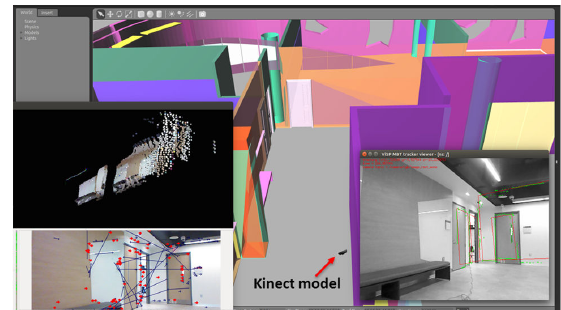
Figure 14: Screen capture of ViSP (bottom right window) running concurrently with RGB-D SLAM (bottom left window) to estimate the camera pose. The Gazebo simulator (background window) is displaying the Kinect in its current pose with respect to the indoor building